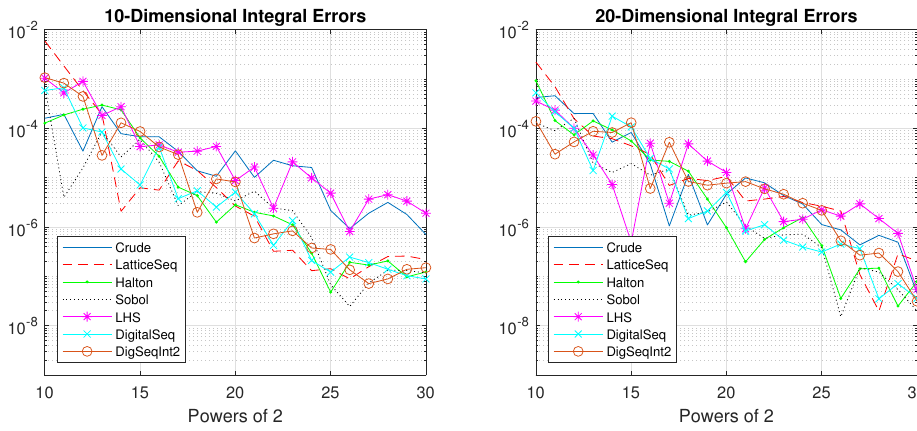
The results for the 10- and 20-dimensional integrals are visualized on Figure 2.